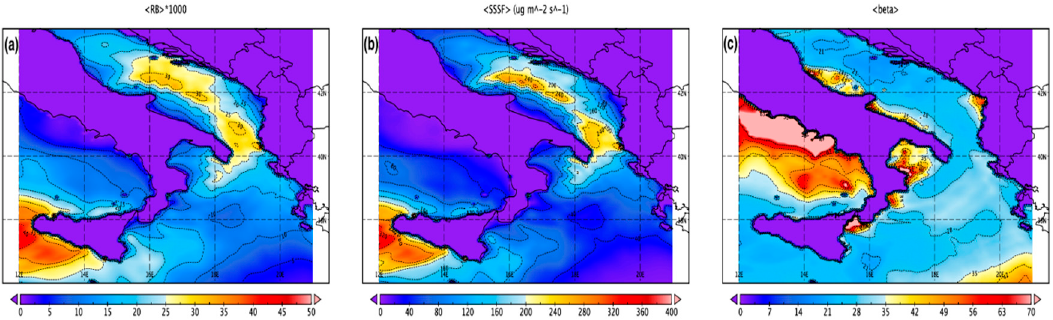
Figure 5. Averaged (0500–2000) UTC 26 September 2006 of wind-sea Reynolds number ( a ); simulated total sea spray emission ( b ); wave age parameter ( c ). total sea spray emission ( b ); wave age parameter ( c